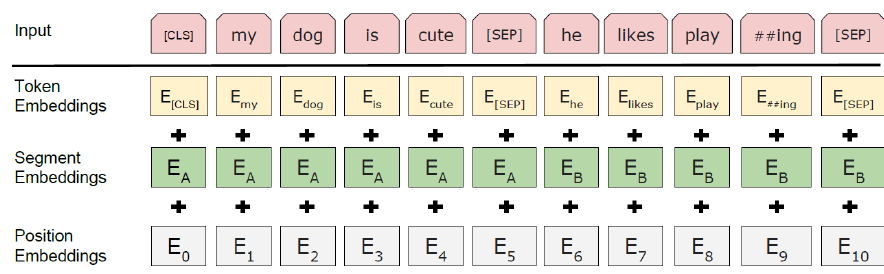
Figure 3. BERT input representation (figure adapted from